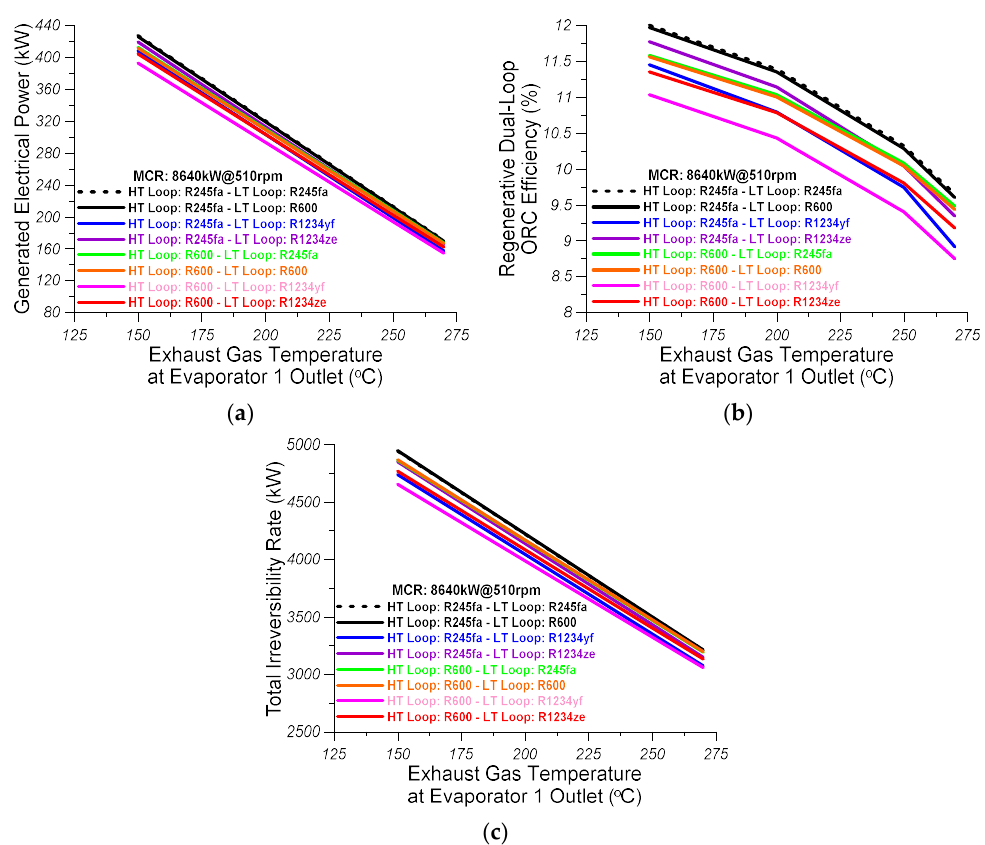
Figure 17. (a) Effect of the exhaust gas temperature after the evaporator 1 of the HT loop on the generated electric power of the regenerative dual-loop ORC; (b) Effect of the exhaust gas temperature after the evaporator 1 of the HT loop on the thermal efficiency of the regenerative dual-loop ORC; (c) Effect of the exhaust gas temperature after the evaporator 1 of the HT loop on the total irreversibility rate of the regenerative dual-loop ORC. Results are given for all the pairs of organic mediums that are examined in the present study.